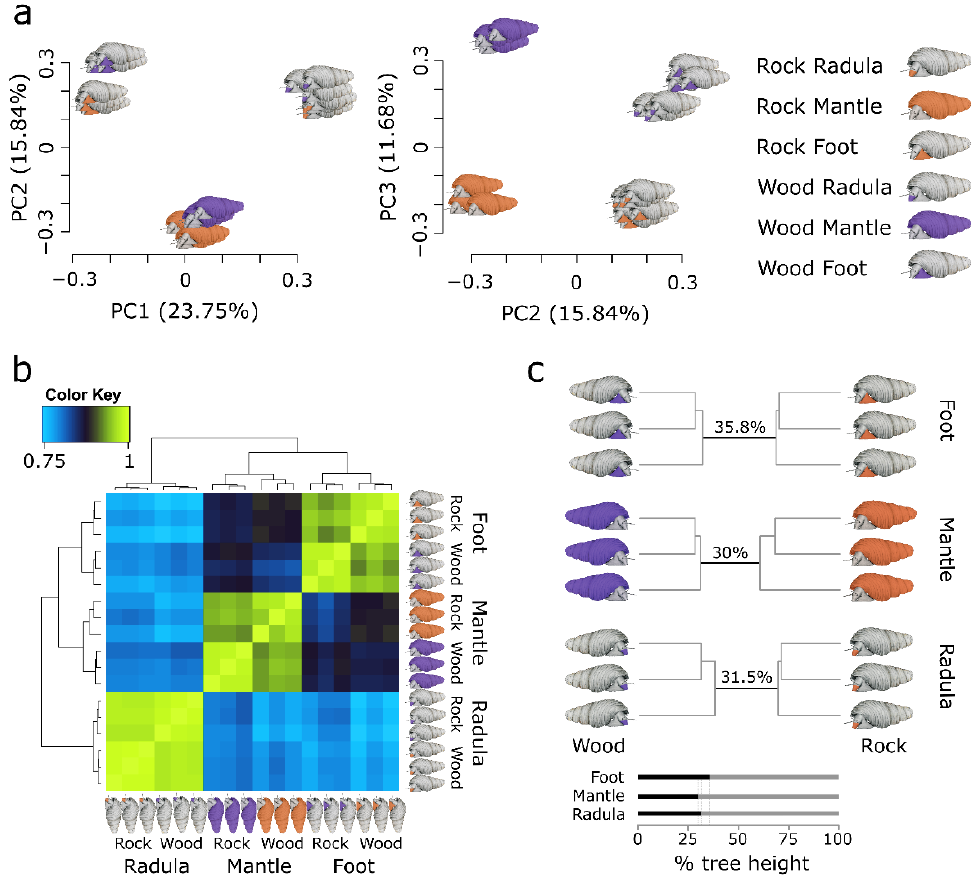
Figure 4. Divergence of gene expression between T. sarasinorum ecomorphs. ( a ) Depicts a principal component analysis of gene expression in radula, mantle, and foot tissue from wood (violet) and rock (orange) ecomorphs. The first two principal components (PCs) primarily separate different tissue types, whereas the third PC separates tissues of different ecomorphs. ( b ) Hierarchically clustered Spearman correlation matrix of gene expression (log 2 transformed counts per million mapped reads). Samples with a more similar gene expression cluster together in the matrix and the hierarchical clustering tree (left and top). Color gradient from blue to yellow shows increasing correlation of gene expression. ( c ) Tree plot illustrating Euclidean distances between samples of each tissue based on expressed genes in that tissue. Relative divergence in overall gene expression between ecomorphs is shown as the branch length separating samples from both ecomorphs (black, bottom).